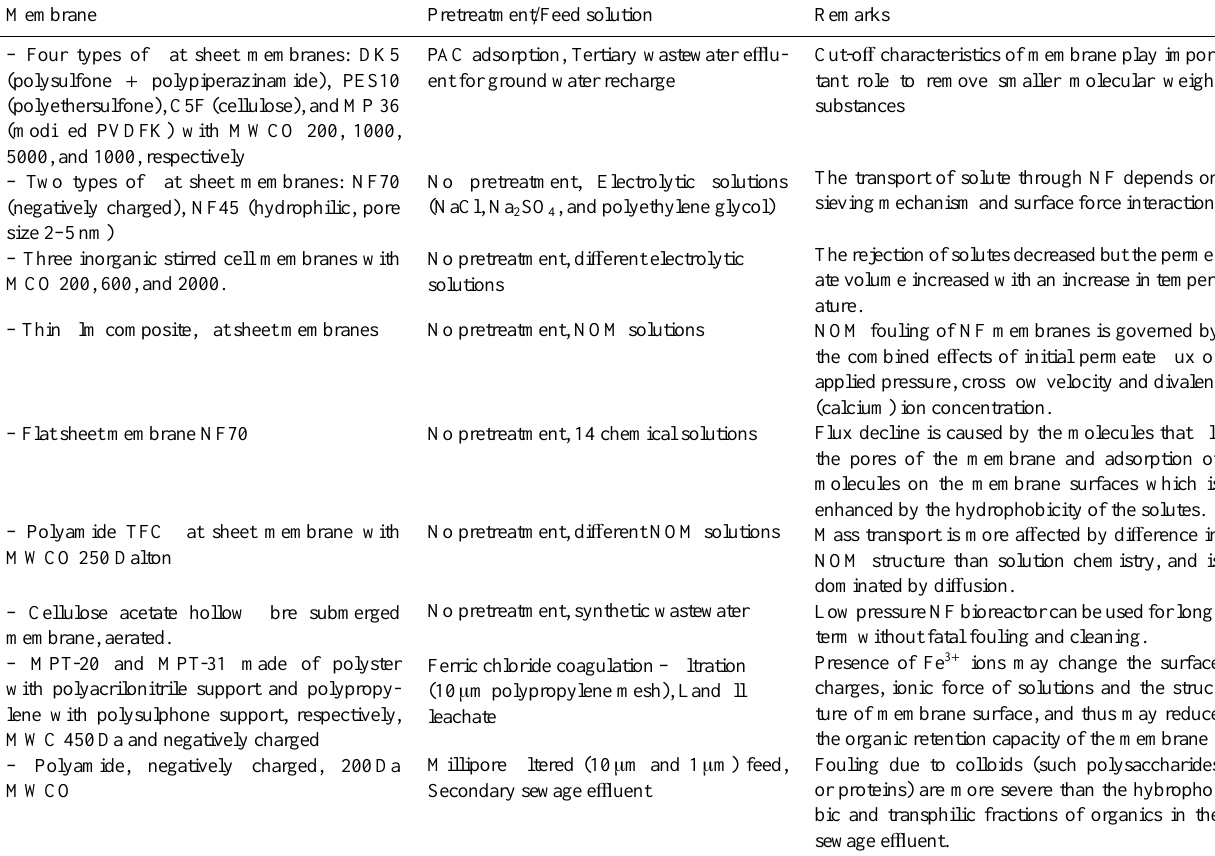
Table 2. Past studies of nanofiltration.